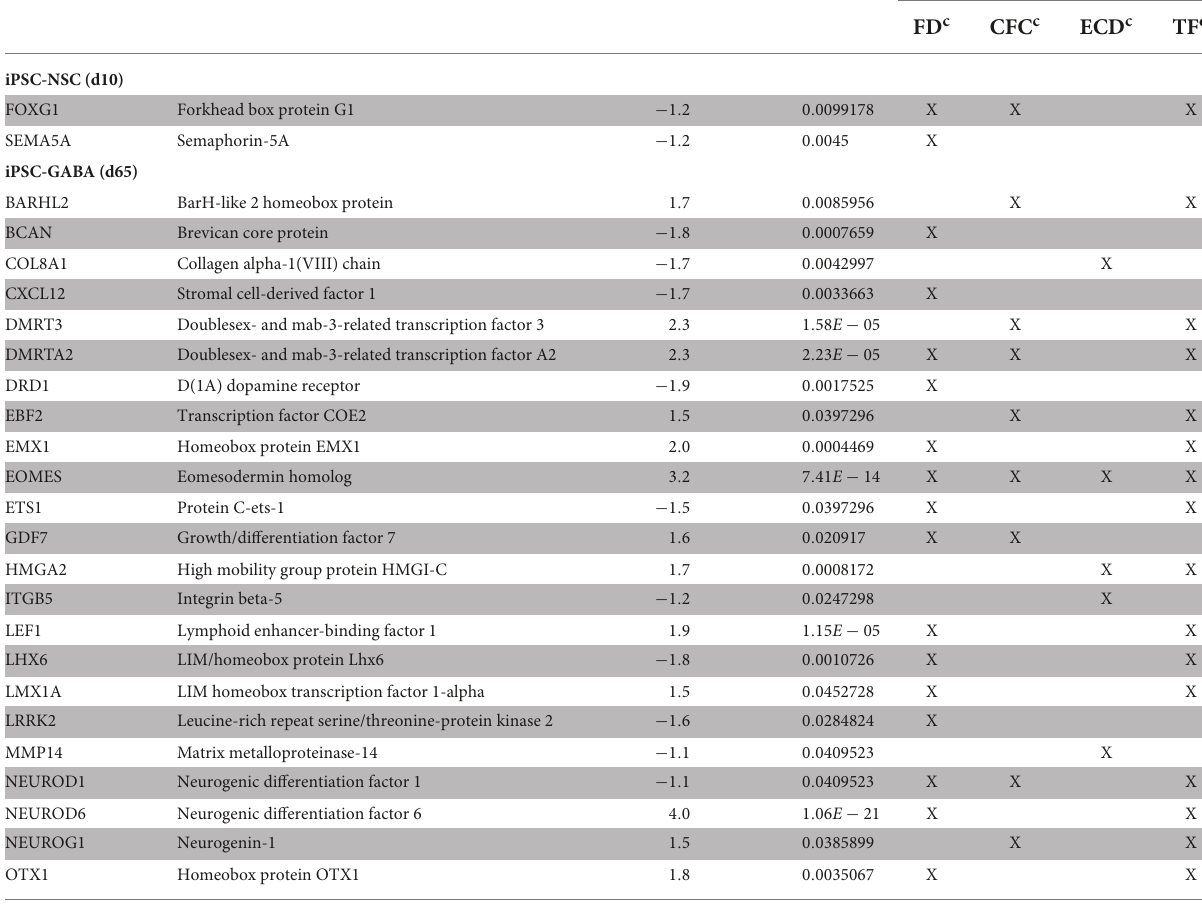
TABLE 1 Differentially expressed genes (DEGs) identified in MW-iPSC NSC and MW-iPSC GABA that belong to the top enriched GO terms for biological processes and molecular functions. Gene